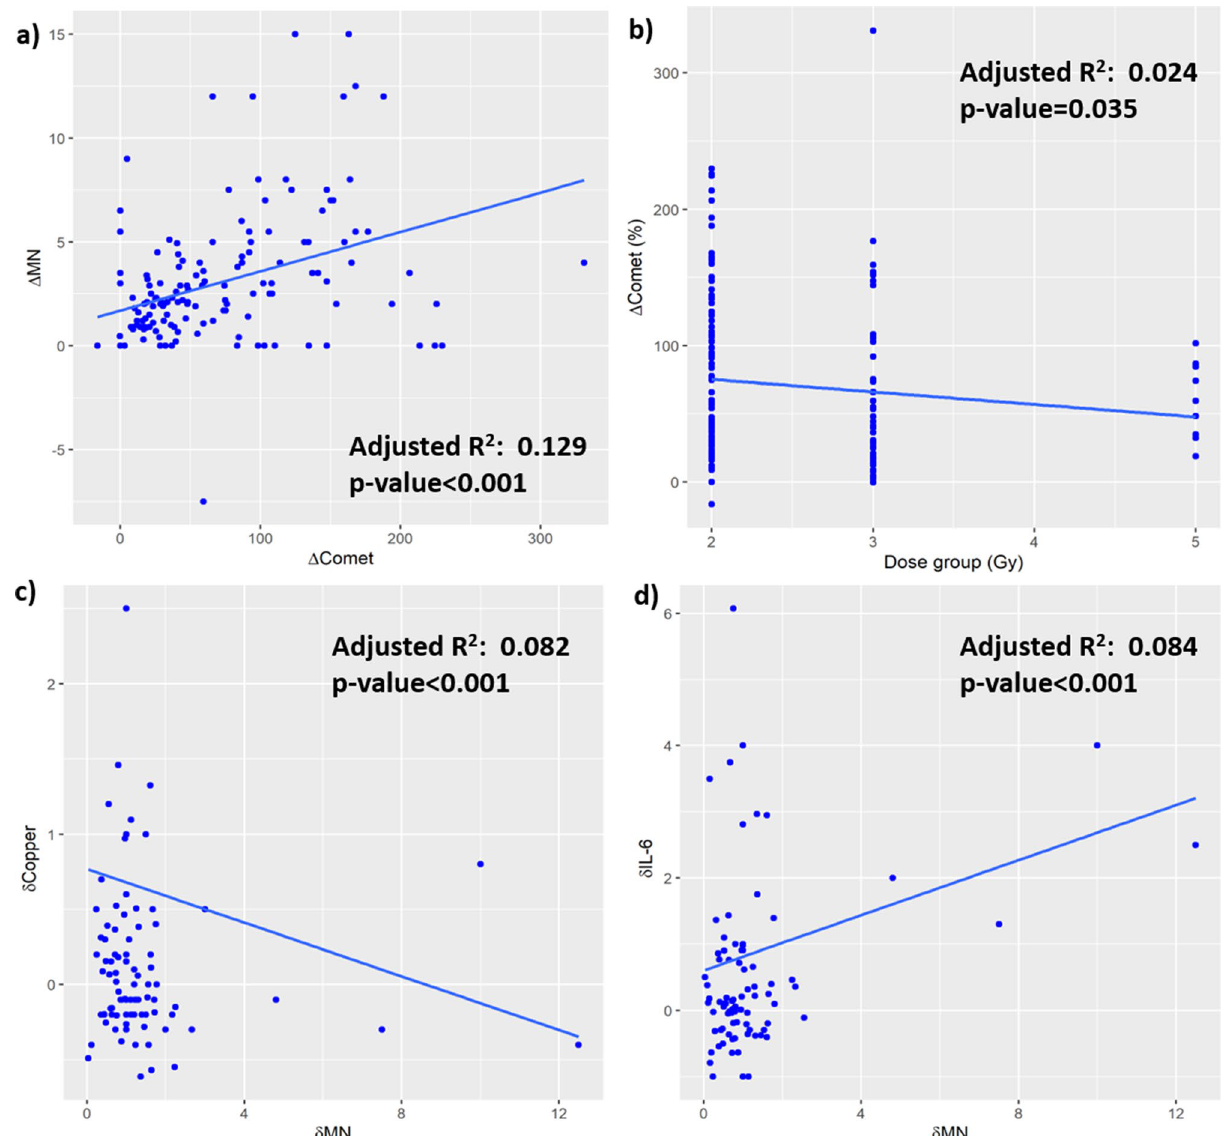
Figure 2. The difference of absolute MN values (before and after the first fraction of radiotherapy) versus the difference of absolute DNA breaks values obtained from Comet assays ( a ) and the PTV dose group ( b ); the change of Copper ( c ) and IL-6 ( d ) values against the percentage values of MN (∆ = absolute difference; δ = relative